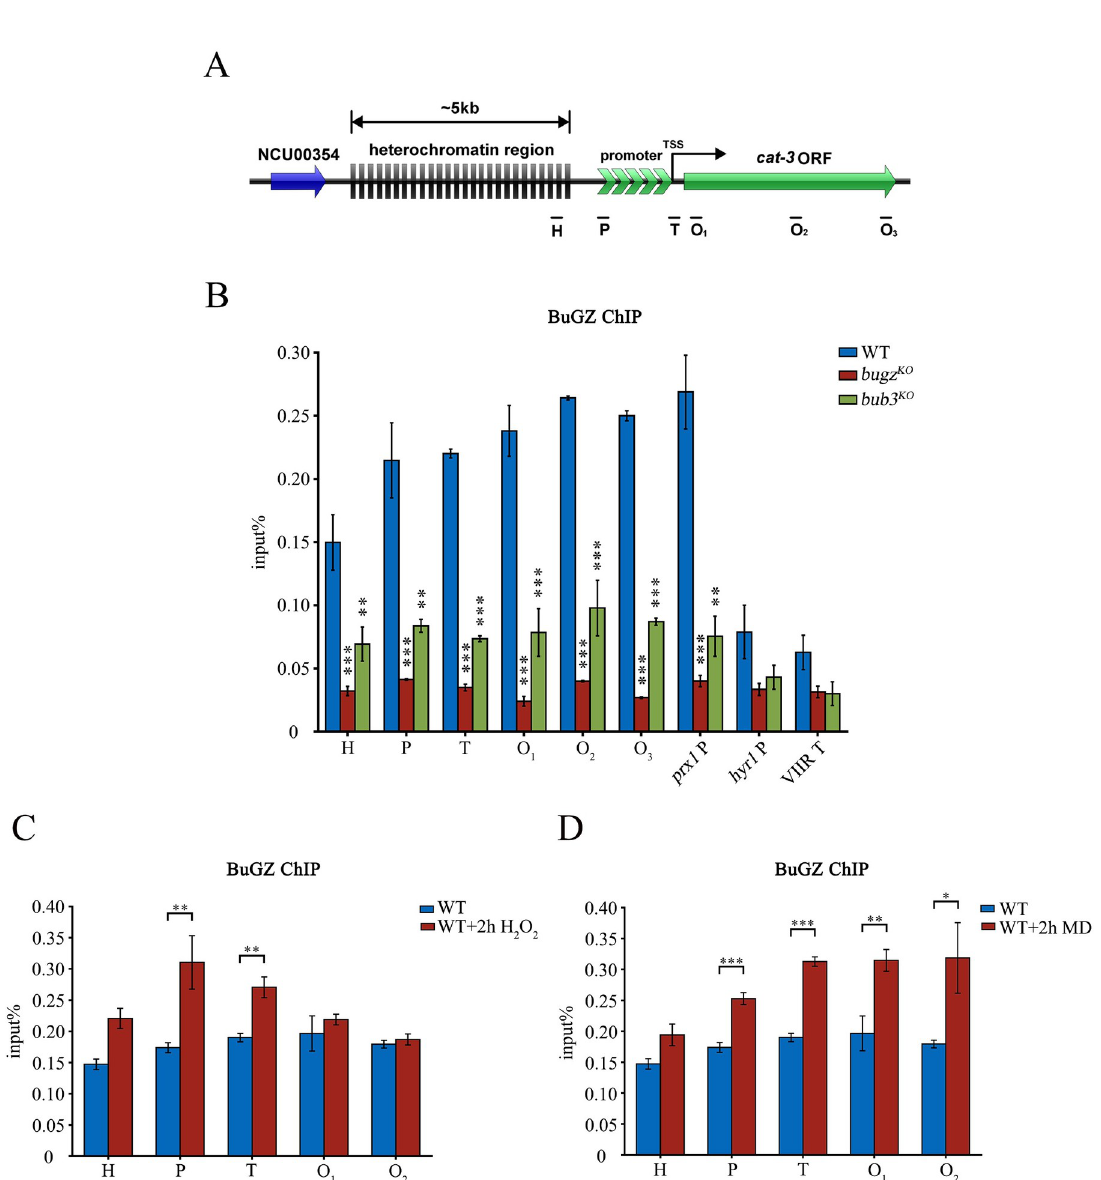
Fig 5. BuGZ binds to the cat-3 gene region specifically and its recruitment responses to cat-3 overexpression caused by oxidative stress. (A) Schematic depicting the location of cat-3 (NCU00355) gene downstream of a 5-kb AT-rich heterochromatin region on linkage group III of Neurospora genome. Site of primer binding are indicated under the schematic. Primer H binds in a heterochromatin region; P in the promoter; T near the transcription start site; O 1 , O 2 , and O 3 in the open reading frame (ORF). (B) Quantification of recruitment of BuGZ to the cat-3 locus as well as control regions in WT and bub3 KO strains. The bugz KO strain was used as a negative control. The prx1 gene promoter region ( prx1 P) was used as a positive binding control for BuGZ, while the hyr1 gene promoter ( hyr1 P) and a telomeric heterochromatin region on the right arm of chromosome VII (VIIR T) were used as negative control groups. (C, D) ChIP analysis of the binding of BuGZ after (C) H 2 O 2 or (D) menadione (MD) treatment for 2 hours at cat-3 locus. Error bars indicate SD (n = 3). Significance was evaluated by two-tailed t -test. � P < 0.05, �� P < 0.01, and ��� P < 0.001.